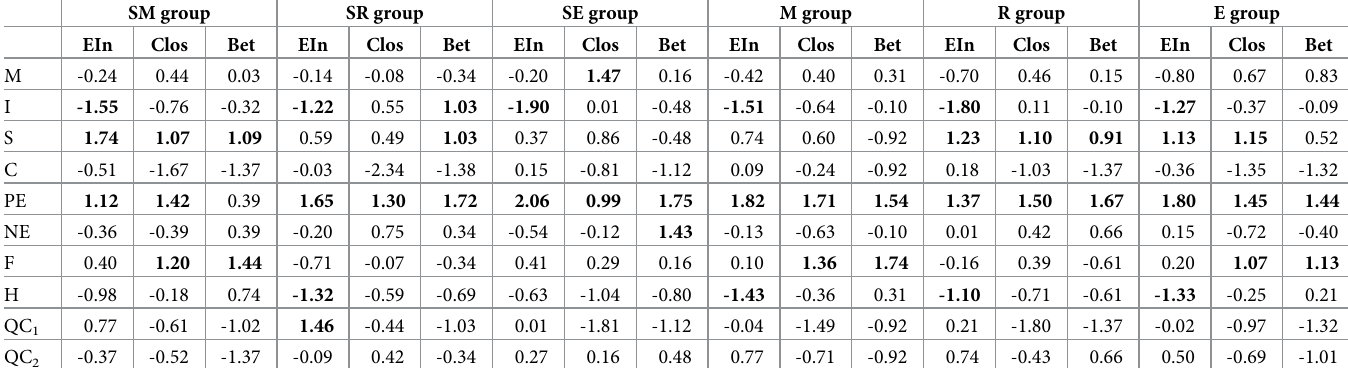
Table 4. Centrality indices of each variable in the six